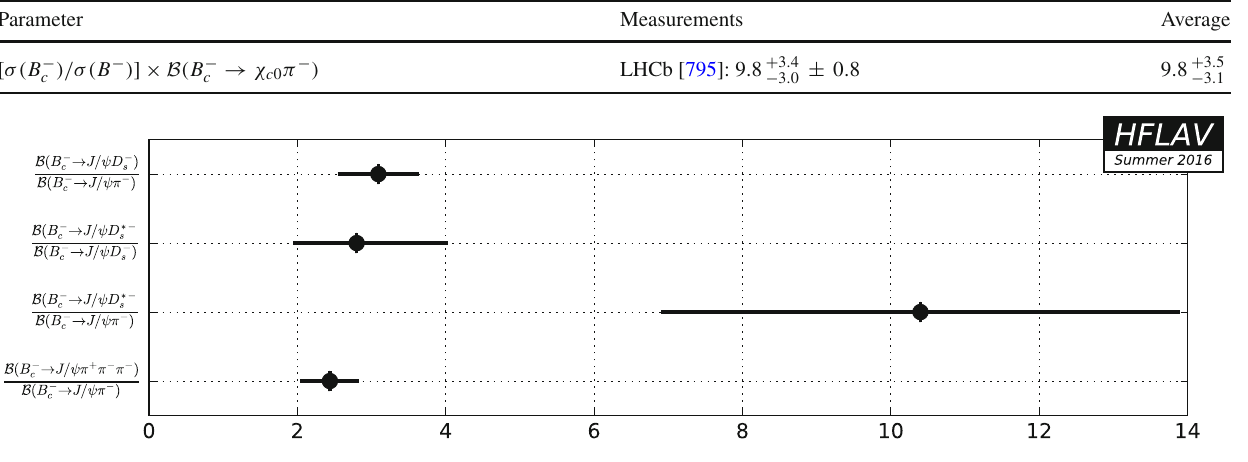
Fig. 166 Summary of the averages from Table 202